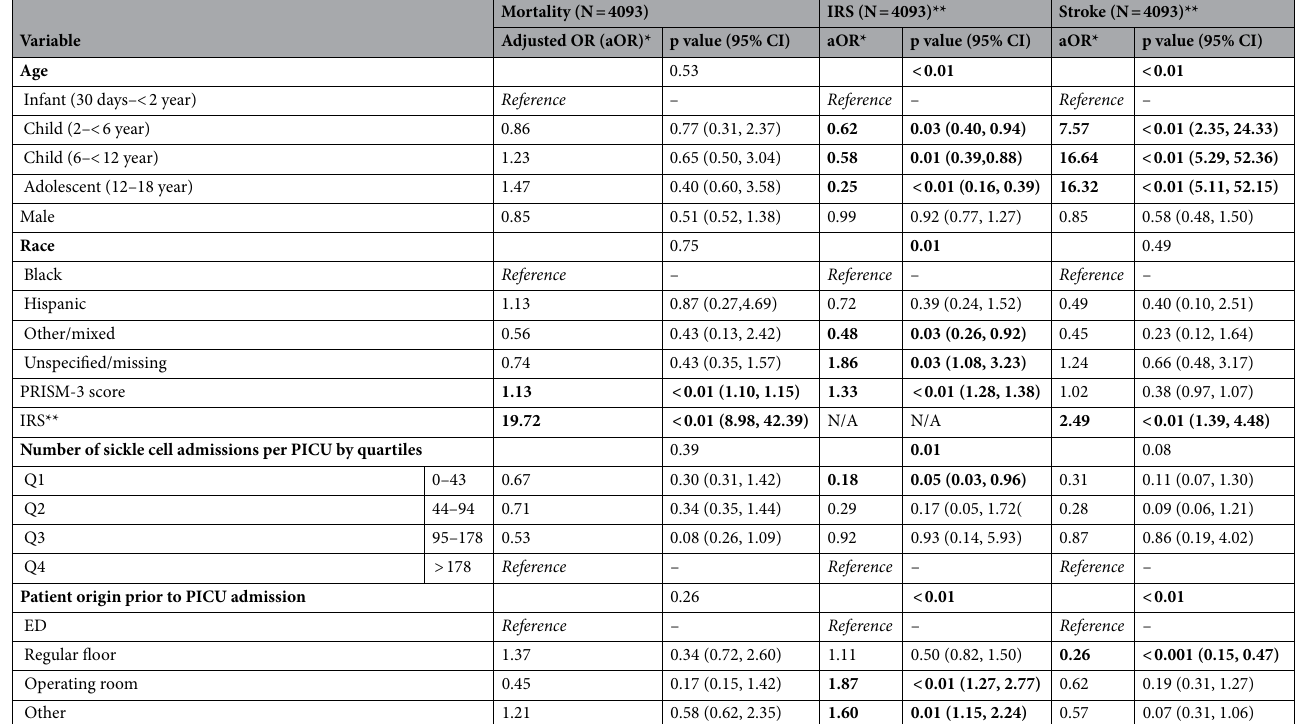
Table 3. Multivariable model of odds ratio for mortality, need for invasive respiratory support (IRS) and stroke. Significant values are in [bold]. *See “Methods” section for details of statistical analysis. **Invasive respiratory support (IRS) and stroke represent composite categories, see